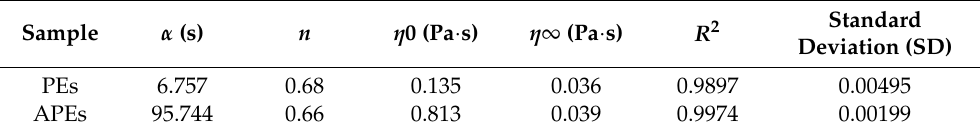
Table 1. Cross model fitting parameters of APEs and PEs at shear rate from 0.1 to 100 (s − 1 ) under ambient